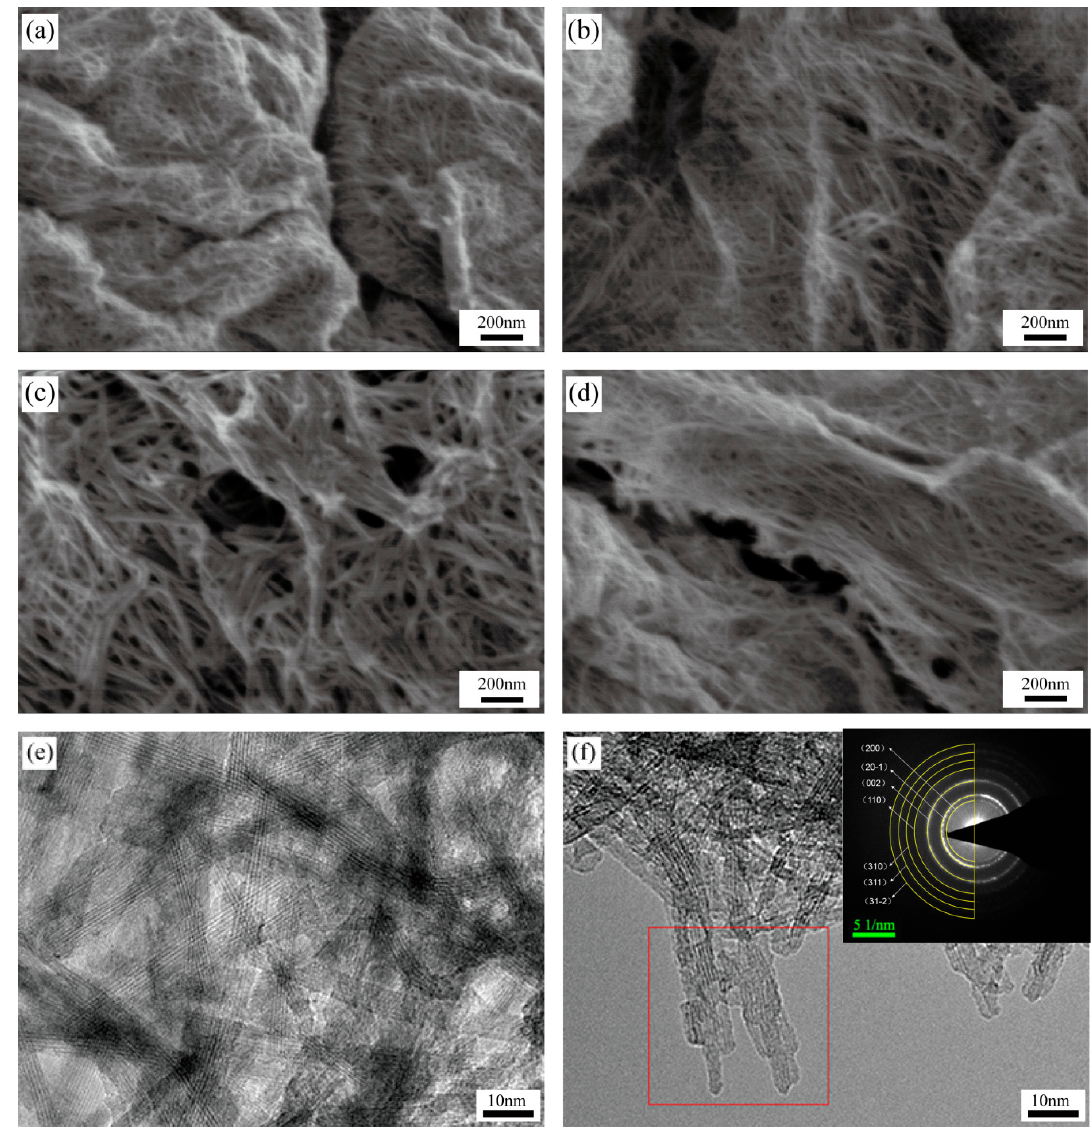
Figure 3. FESEM images of KTO ( a ), 0.5 Cu–KTO ( b ), 1.0 Cu–KTO ( c ), 1.5 Cu–KTO ( d ), and TEM images of KTO ( e ) and 1.5 Cu–KTO ( f ). Insert in ( f ) shows the respective SAED pattern.